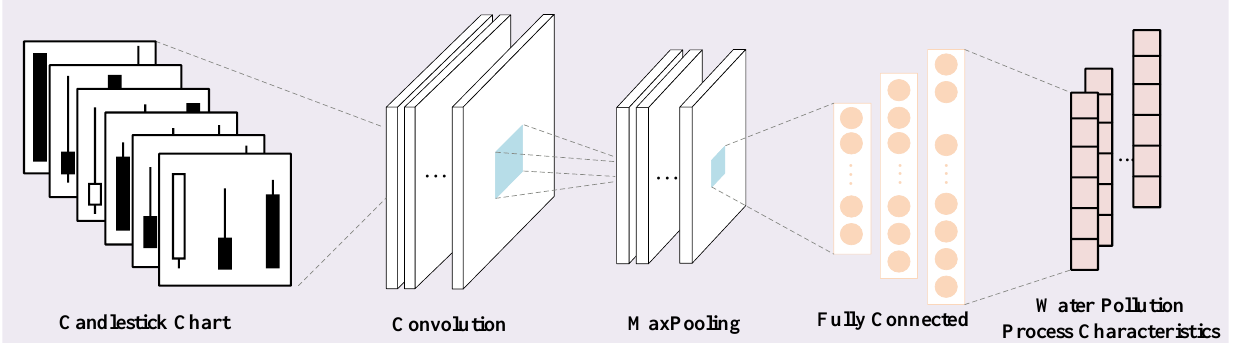
Figure 4. VGG extracted the candlestick chart features for classification. As shown in Figure 4, the candlestick chart of water quality data generated by the candlestick chart generator for three consecutive days was used as the input of the VGG network. Corresponding to category 2 in Table 1, concentrations increased